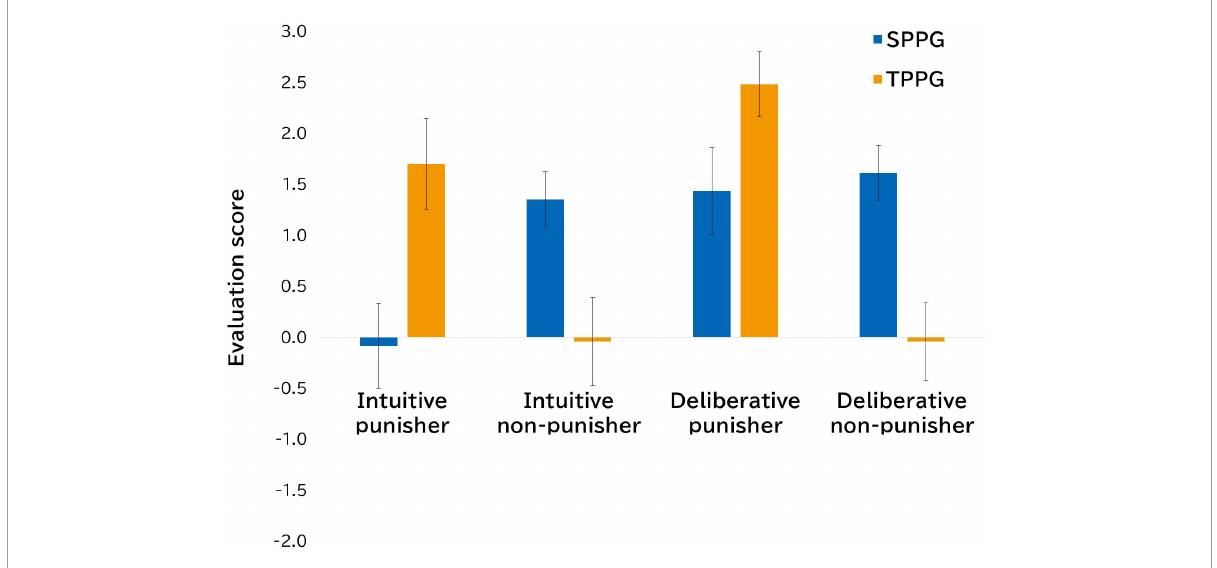
FIGURE3 Conditional differences in mean evaluation scores of intuitive (non-) punisher and deliberative (non-) punisher (Study